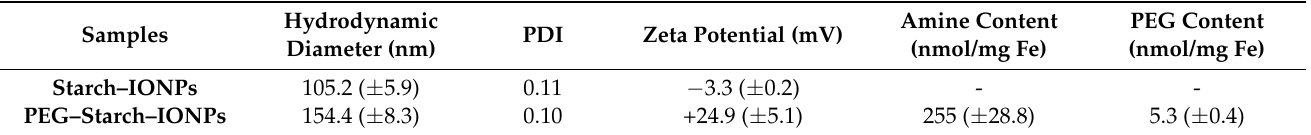
Table 1. Physicochemical properties of starch–IONPs and PEG–starch–IONPs 1 .